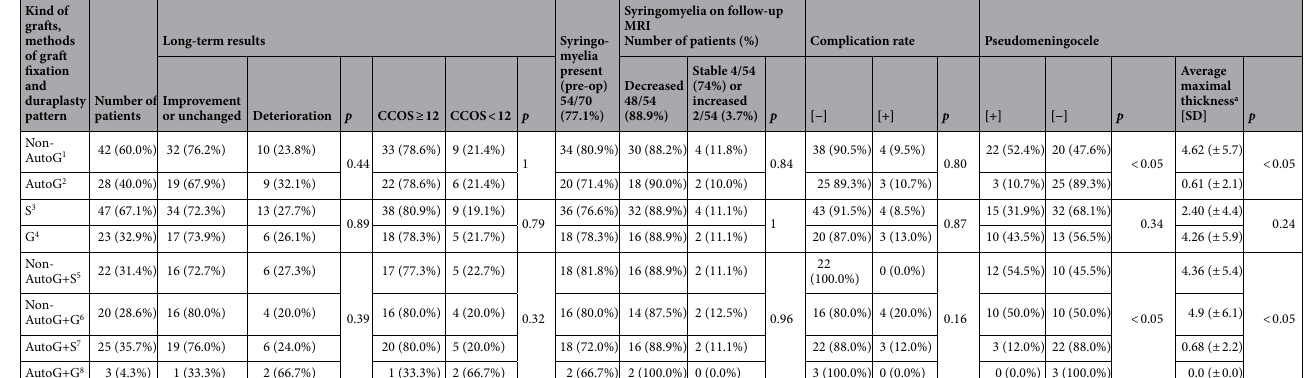
Table 3. Follow-up summary of clinical and radiological outcomes stratified by the type of grafts used, graft fixation methods and duraplasty materials during decompression surgery in patients with Chiari I malformation. 1 Nonautologous graft, 2 Autologous graft, 3 Graft fixed with sutures, 4 Graft fixed with glue only, 5 Nonautologous graft fixed with sutures, 6 Nonautologous graft fixed with glue only, 7 Autologous graft fixed with sutures, 8 Autologous graftfixed with glue only. a Maximal perpendicular distance to graft measured on sagittal T2 MRI images (mm).